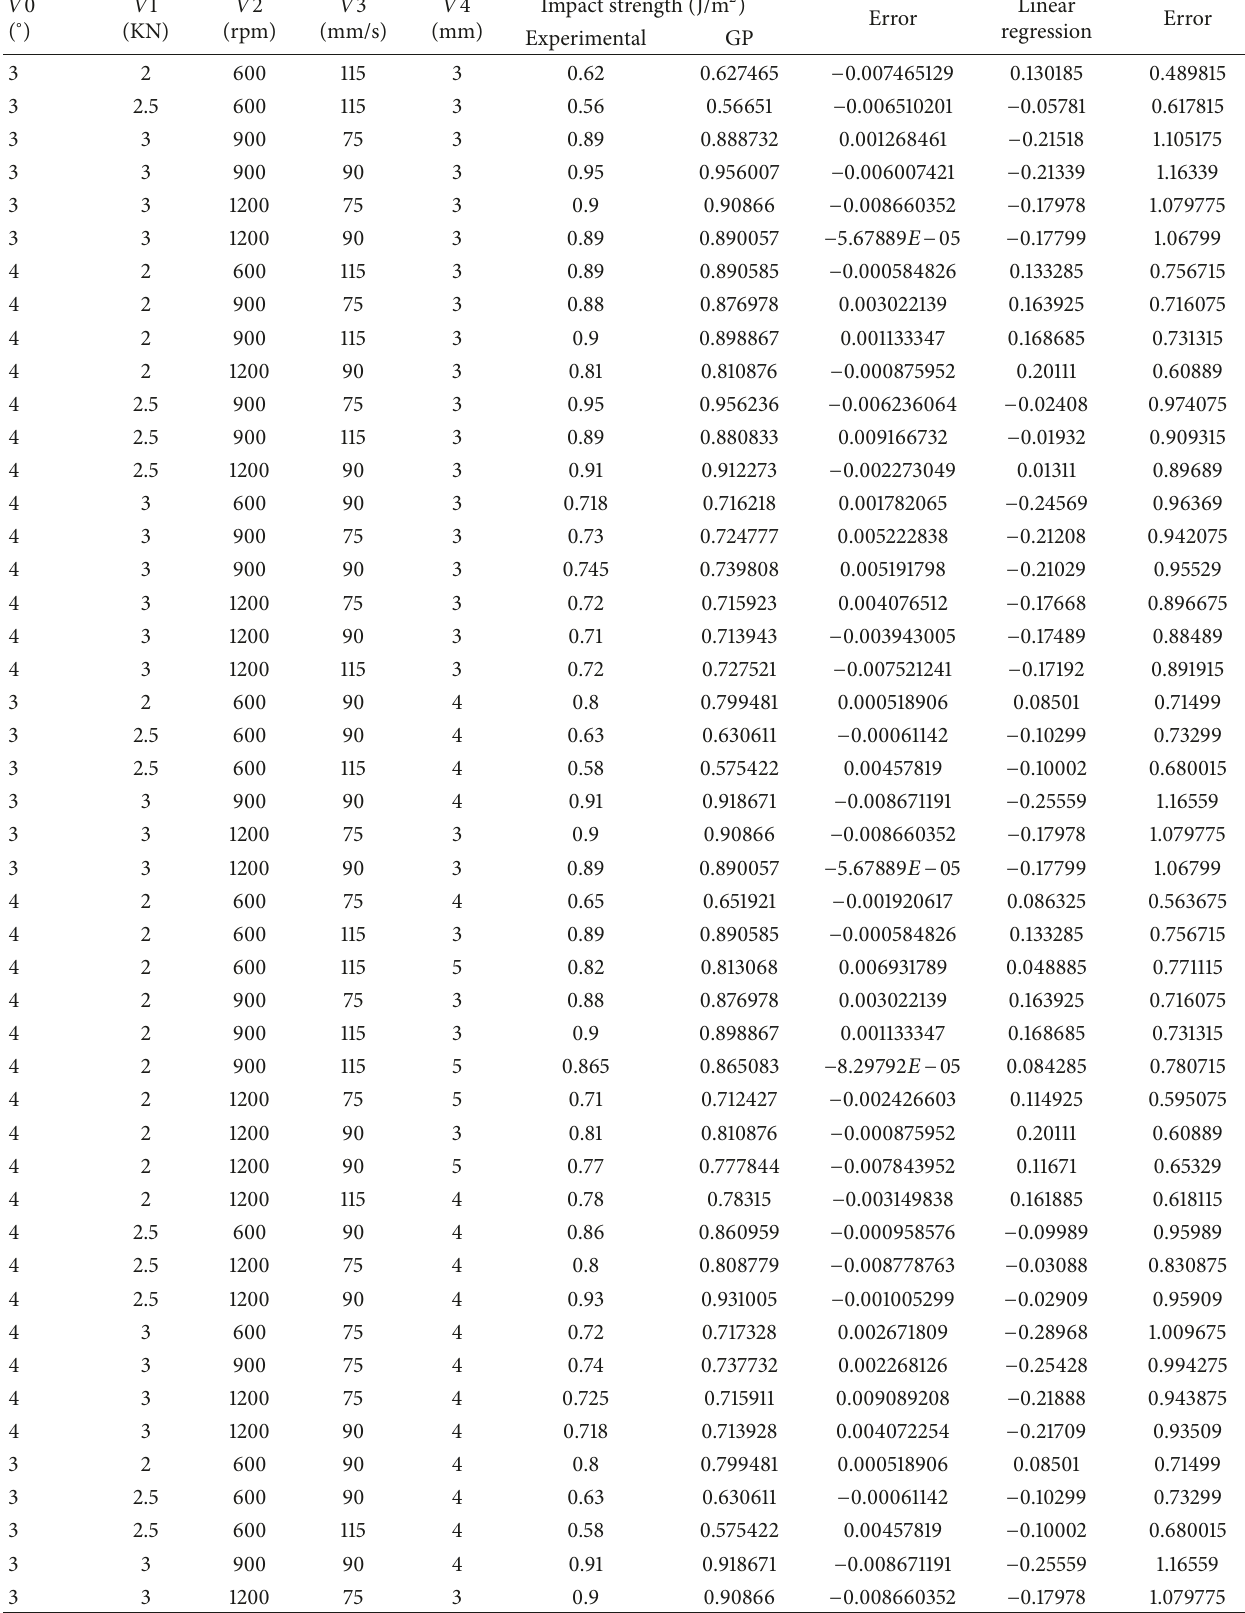
Table 6: Comparison between experimental and predicted values of impact strength at R 2 = 99.4